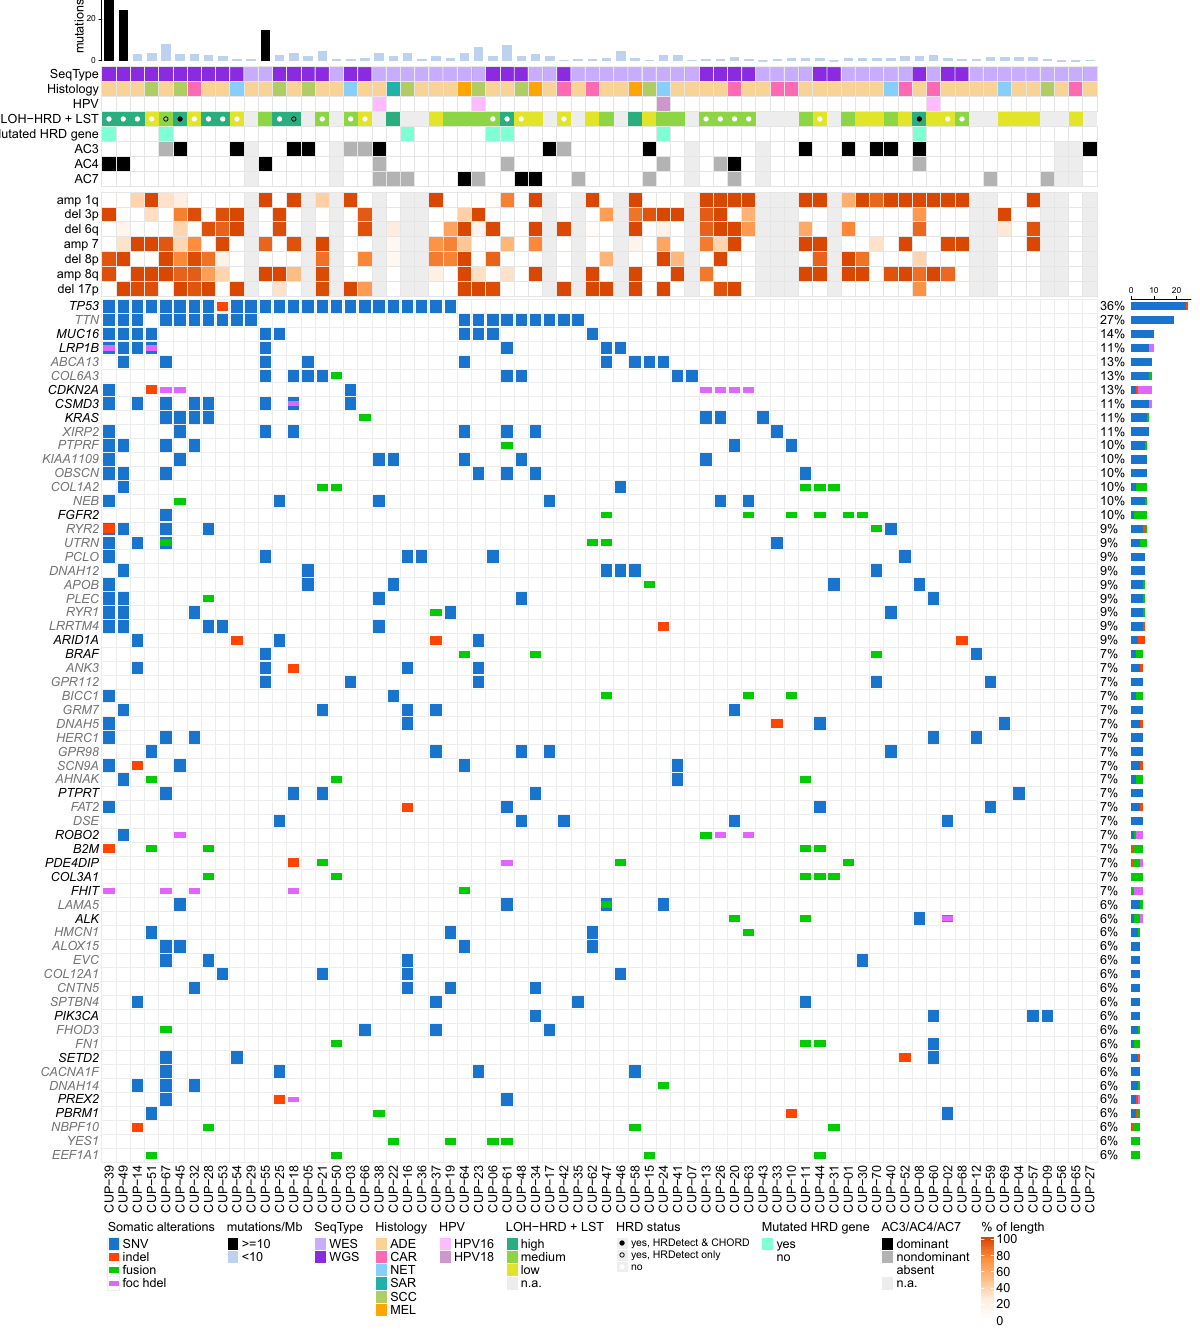
DNAH7 , ESRRA , LMTK2 and ZNF107 ( n = 2 each). Based on RNA sequencing, we detected 0 to 61 (median = 10, mean = 15) gene fusions of high con fi dence per patient, many of which were of unclear relevance. In 17 patients we detected fusions with predictive or diagnostic relevance (Supplementary Data 3). The genes that were most commonly involved in these fusions were FGFR2 (6 patients), EML4 - ALK (3 patients), BRAF (3 patients) and EWSR1 - WT1 (2 patients). In four cases the FGFR2 fusion was intrachromosomal and included inversions ( n = 3, twice with BICC1 ), translocations ( n = 2) and a deletion ( n = 1). All samples tested for microsatellite instability (MSI) were microsatellite sta- bile (MSS, n = 69). Analysis of somatic copy number aberrations